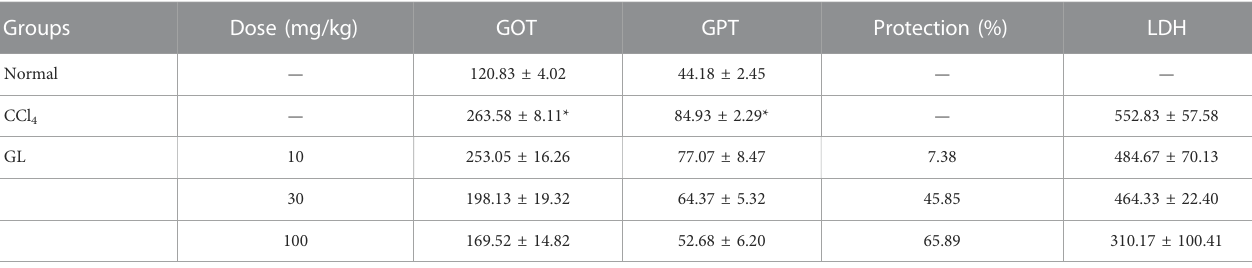
TABLE 5 Hepatoprotective effect of raw herbal extracts on CCl 4 -induced increase in GOT GPT levels.